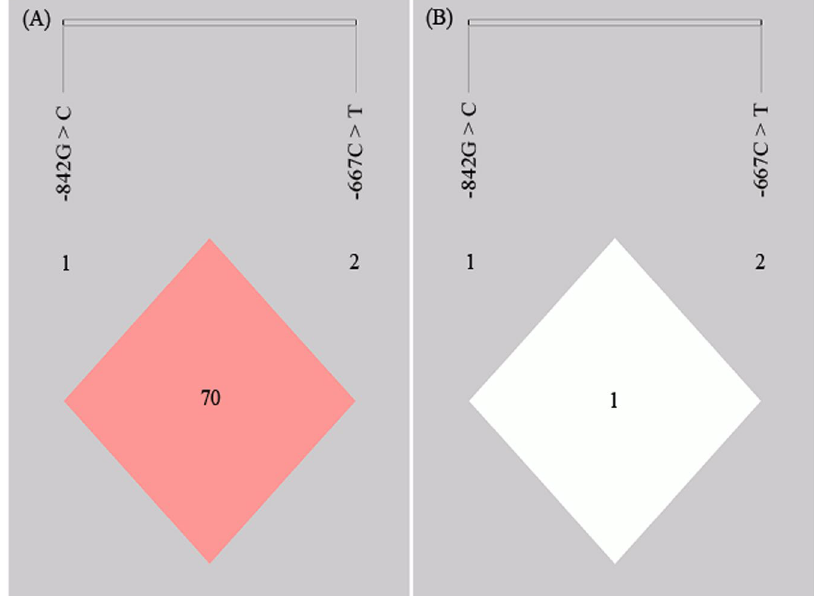
Figure 1. Linkage disequilibrium (LD) for the two SNPs of PIN1; ( A ) D ′ and ( B ) r 2 values.